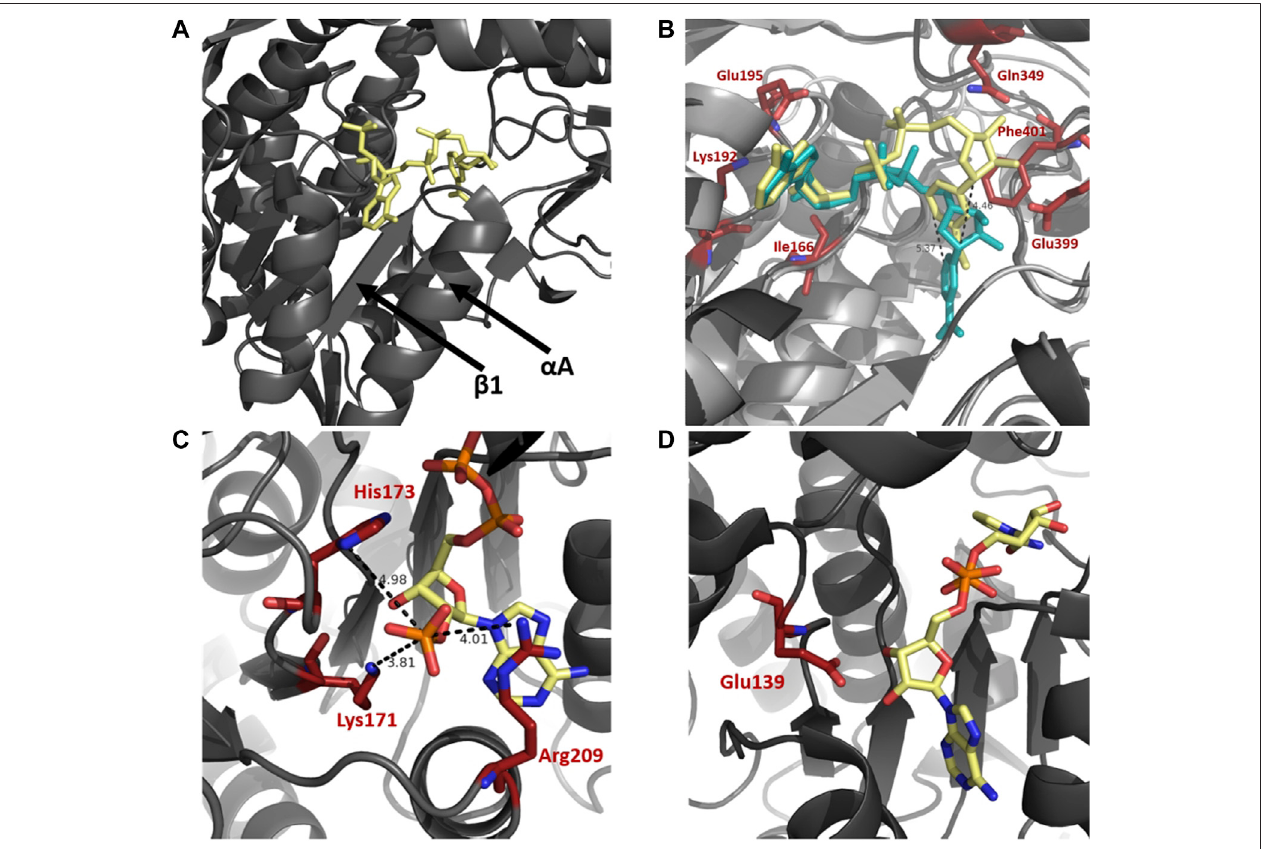
FIGURE 4 | Cofactor binding mechanism of ALDH. (A) Depiction of α A and β 1 of the Rossmann fold in the cofactor binding domain. (B) Varying conformations of thenicotinamide portionandconstantorientationofadenineringofNADdemonstratedonsheepALDH1andbovineALDH2(PDB:1BXSand1A4Z).ALDH1(darkgray) and ALDH2 (light gray) are modeled as an overlay with NAD in yellow and blue, respectively. Measurements demonstrate an approximate 5 Å shift of the nicotinamide portion. Key cofactor binding residues are highlighted in red. Residues 241 – 253 have been omitted for visualisation purposes. (C) NADP 2 ′ phophate shown in close proximity to Lys171, His173, and Arg209, no acidic residue is present in the NADP dependent ALDH from V. Harvei (PDB: 1EYY). (D) Human ALDH3A1 (PDB: 4L2O), a non-obligatory NADP ALDH, shows a NAD cofactor in close proximity to Glu139 even though this ALDH can utilise